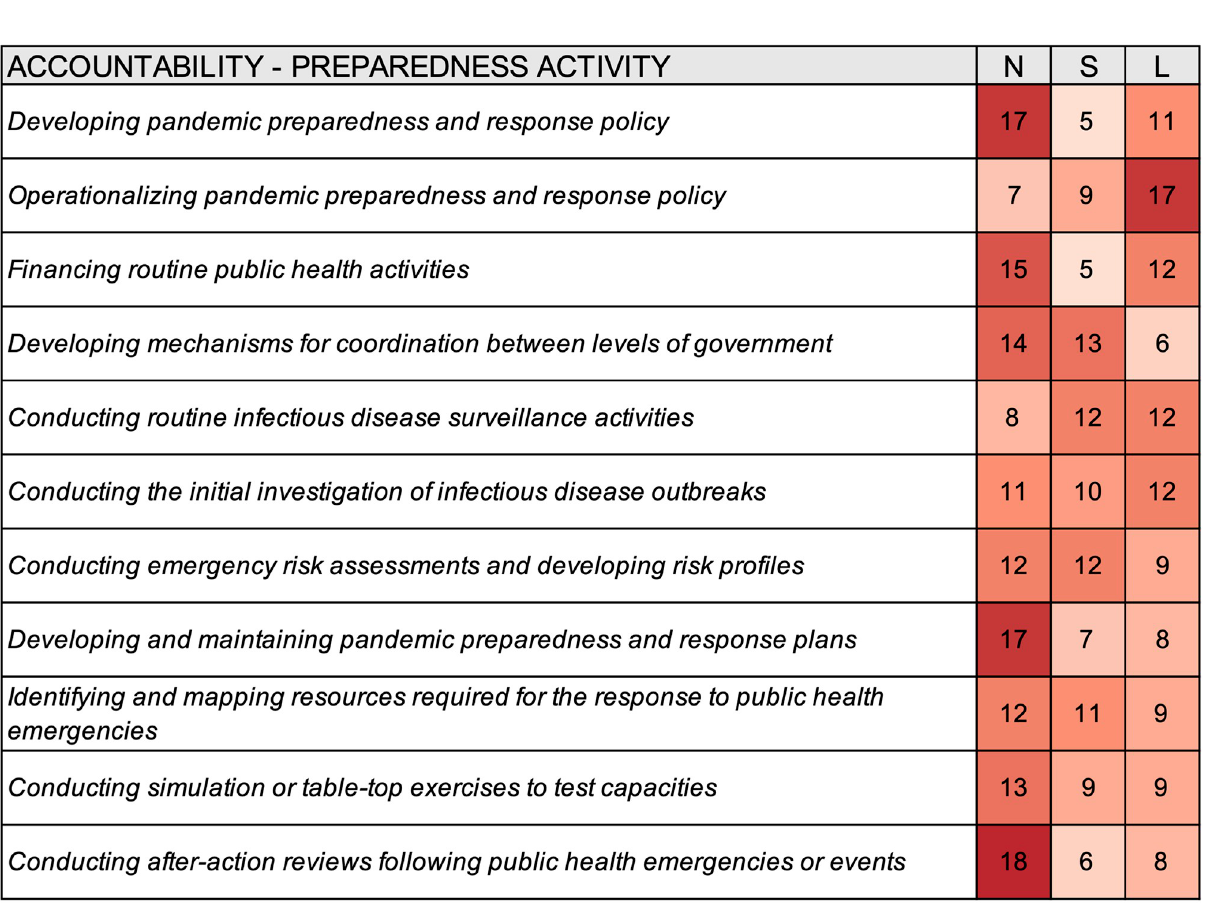
Fig 3. Heat map summarizing the accountability for select preparedness activities for different levels of government according to survey responses from thirty-three cities. N–National, S–Subnational, L–Local.